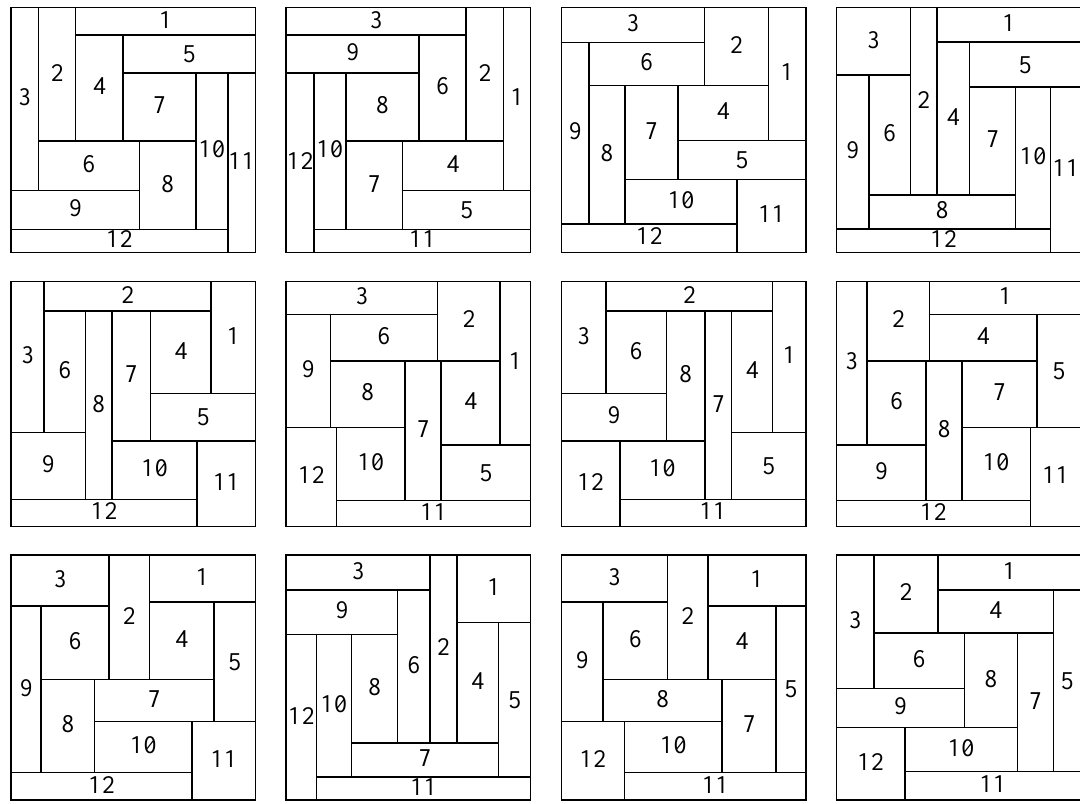
Figure 4: Smith diagrams for the planar network of Figure 3, with energies 1. Here Galois group acts transitively: the underlying number field for each tiling is a degree-12 totally real extension field of Q . Each tiling corresponds to a different bipolar orientation of G , so these tilings are not